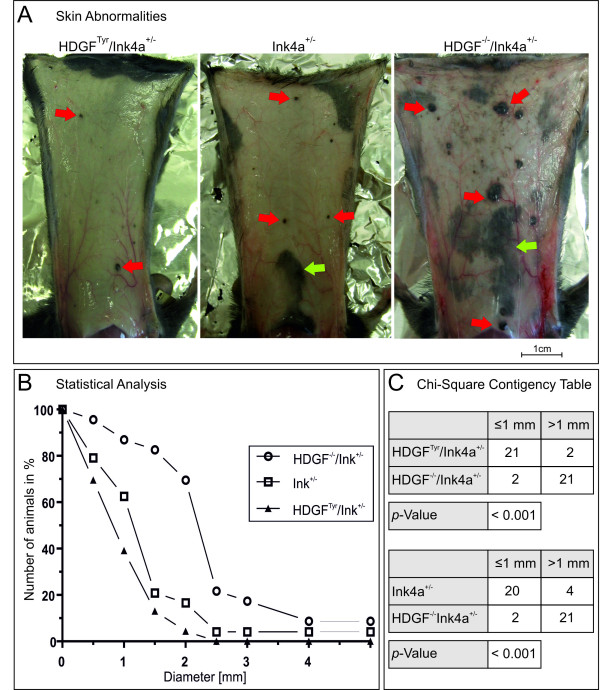
Statistical analysis of pigmented skin abnormalities (PSA). A: Overview of the inner side of skins from HDGFTyr/Ink4a+/-, Ink4a+/-, and HDGF-/-/Ink4a+/- mice showing PSA. Scale bar equates 1 cm. B: Statistical analysis of the occurrence of (PSA) of the different genotypes. HDGFTyr/Ink4a+/- n = 23, Ink4a+/- n = 24; HDGF-/-/Ink4a+/- n = 23. C: Chi-square contingency table was applied for the category: largest PSA was ≤ 1mm or > 1mm. Contingency tables were carried out for the following pairs of genotypes: HDGFTyr/Ink4a+/- - HDGF-/-/Ink4a+/- and Ink4a+/- - HDGF-/-/Ink4a+/-. Analysis was regarded significant for p < 0.01.